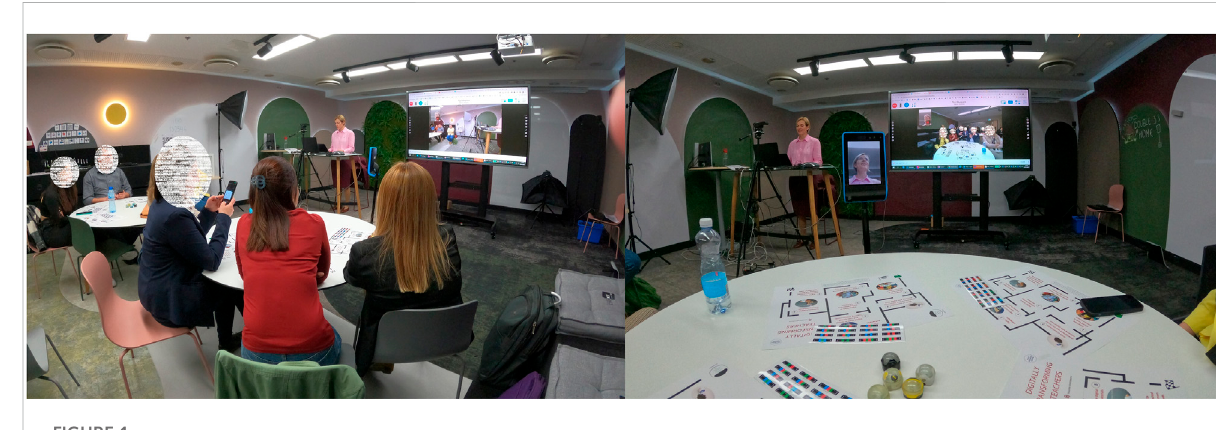
FIGURE 1 Practical demonstration and experimentation of a